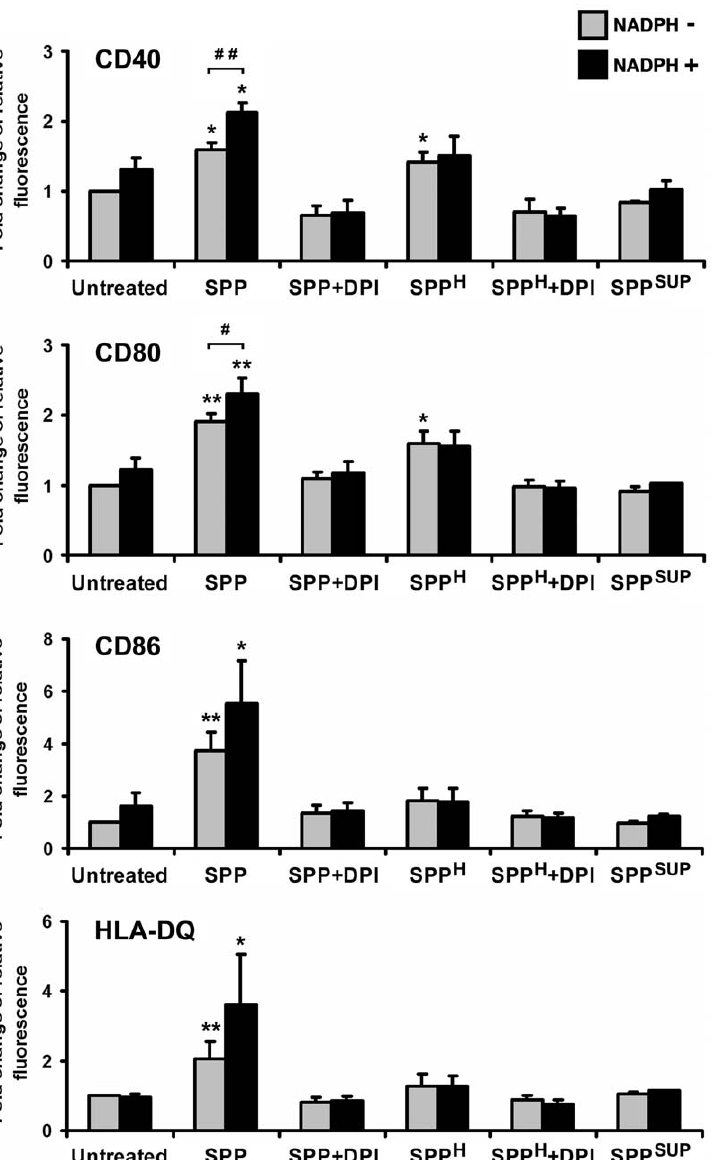
Figure 4. Phenotypic characterization of SPP-exposed human moDCs. Cells were treated with freshly isolated SPPs, DPI-treated SPPs, and heat-inactivated SPPs, individually and in combination with NADPH for 24 h. Expression of HLA-DQ and co-stimulatory molecules was analyzed by means of flow cytometry. Data are presented as means 6 SEM of four independent experiments. * p , 0.05; ** p , 0.01; *** p , 0.001 vs untreated DCs, # p , 0.05; ## p , 0.01. (DPI: diphenyleneiodonium; SPP: subpollen particle; SPP H : heat-inactivated SPP; SPP SUP : supernatant of